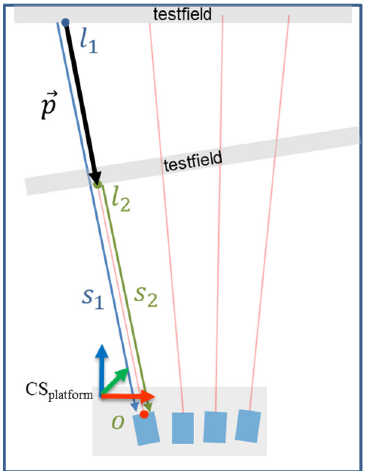
Figure 10. Concept for relative orientation with moving testfield; coordinate system on the platform of meter system (CS platform) ; p (cid:4652)⃗ direction vector; s 1 and s 2 measured distances